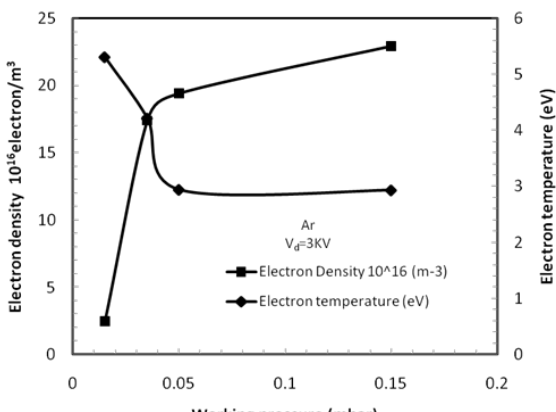
Fig. 6: Variation of the working pressure as function of plasma electron density and temperature.